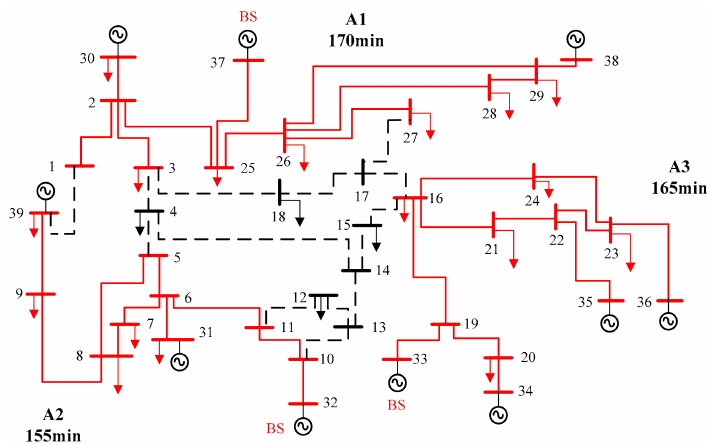
Figure 5. Bus points for group A1, A2 and A3 after first searching step.